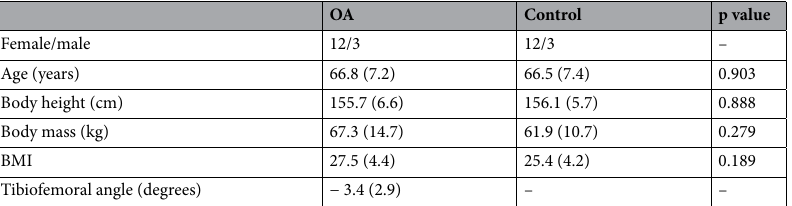
Table 1. Means (standard deviations) of the demographic characteristic of subjects in the knee osteoarthritis group (OA, n = 15) and healthy controls (Control, n = 15). *OA significantly different from